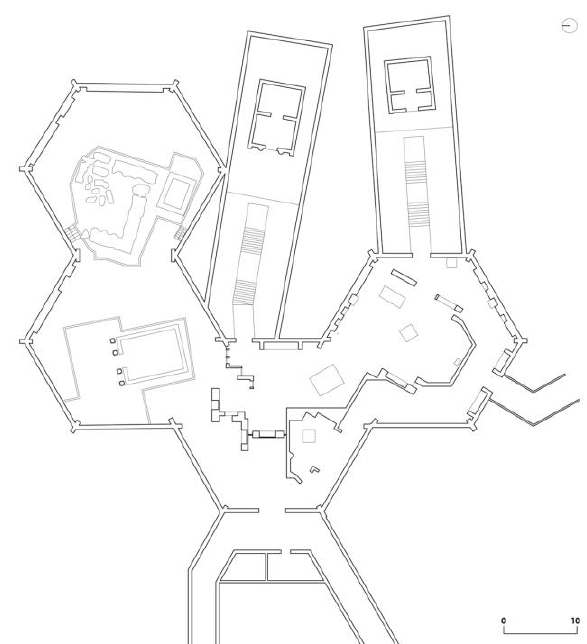
Figure 13. The Tomb of Persephores in Verghina. Cloud of points with noise.